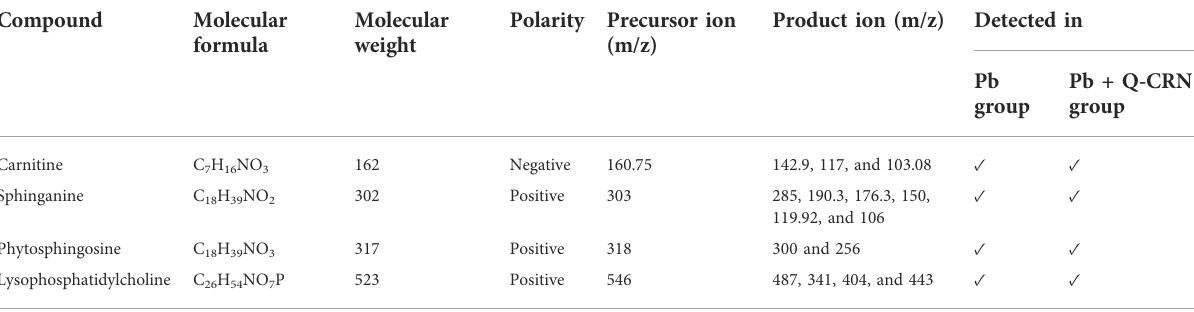
TABLE 3 Compounds detected and con fi rmed in the serum sample of